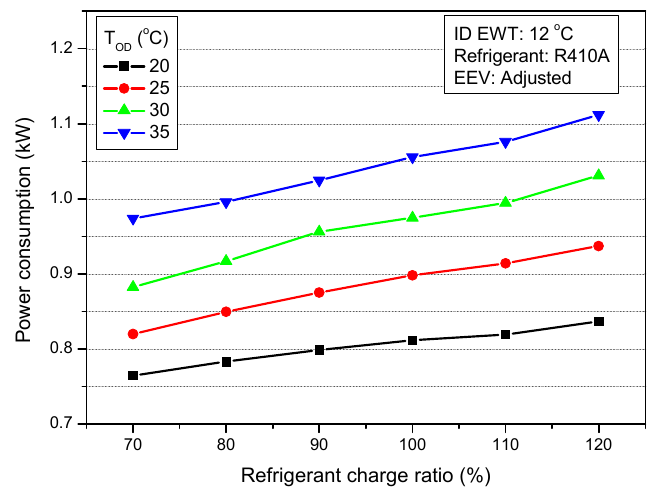
Figure 6. Power consumption with variation of refrigerant charge amount and T OD .